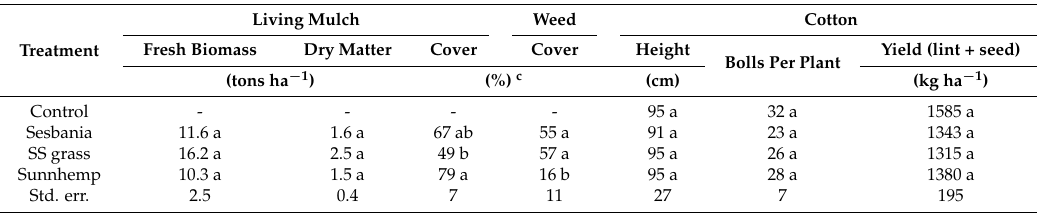
Table 4. Least squares means of cotton, living mulch and weed parameters from data pooled across Sites 1 and 2 during Year 1 a,b .